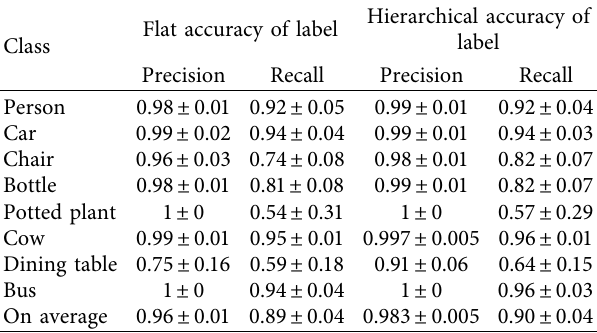
Table 6: Annotation accuracy of human annotations for the se- lected images of the PASCAL 2007 dataset (the average values are computed for the twenty classes).